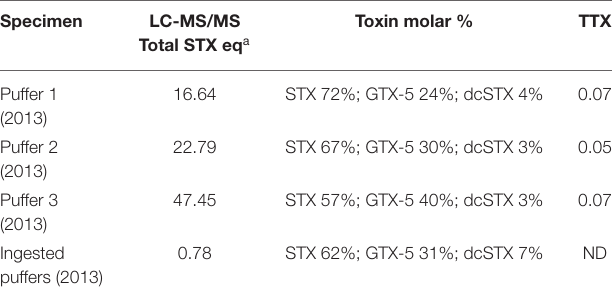
TABLE 3 | Results of high-performance liquid chromatography-tandem mass spectrometry (LC-MS/MS) analyses of Caribbean sharpnose puffer fish ( Canthigaster rostrata ) collected during a mortality in 2013 that was concurrent with strandings of green sea turtles ( Chelonia mydas